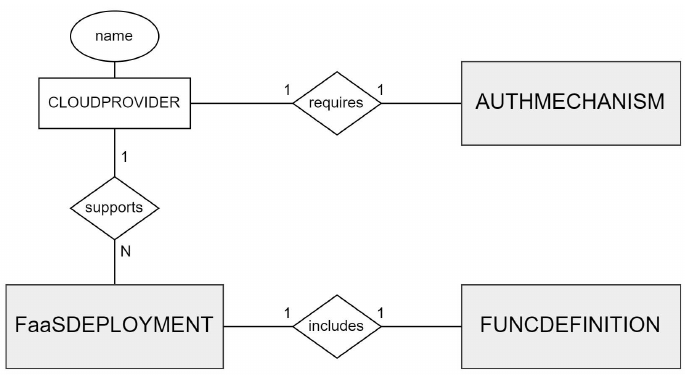
Figure 1. Abstract ERM of the cloud-agnostic